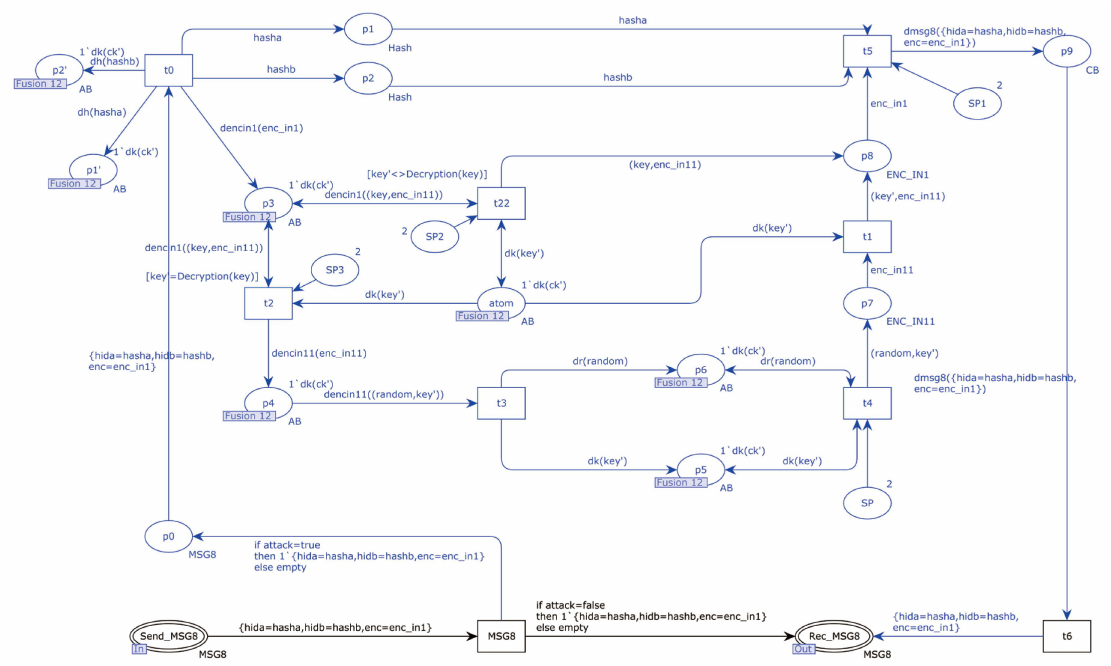
Figure 15. KCIA at the network transport layer.